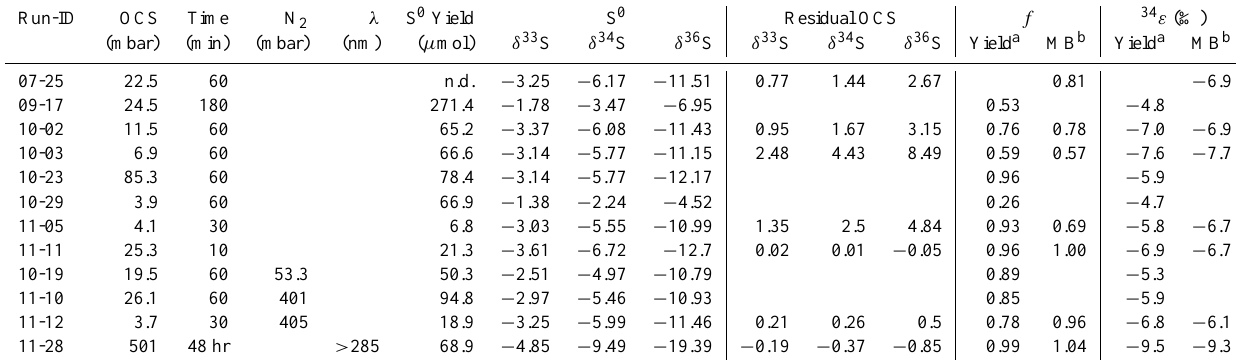
a Residual OCS derived from S 0 yield. b That derived from isotope mass